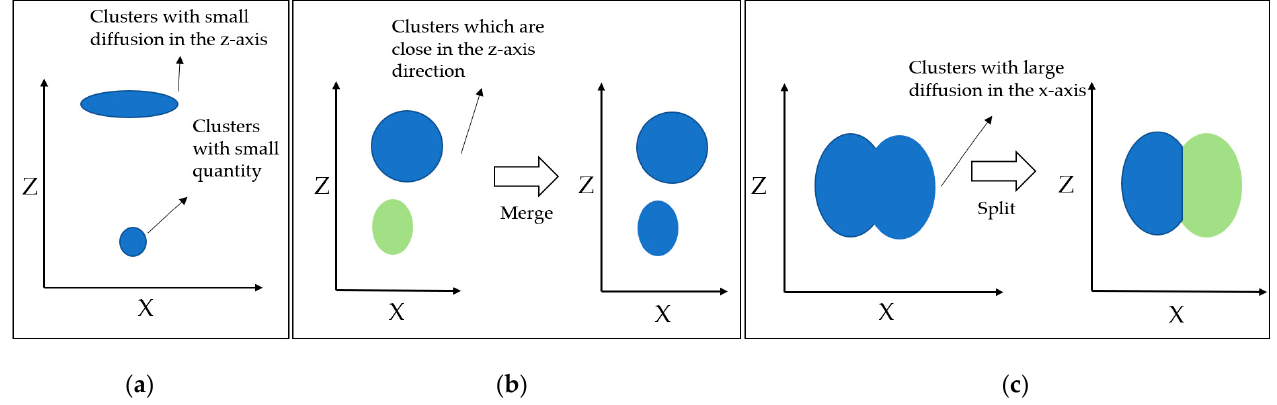
Figure 6. Target clusters for post-clustering processing rules: ( a ) clusters with small diffusion in the z-axis and clusters with small quantities will be filtered; ( b ) clusters that are close in the z-axis direction will be merged; ( c ) clusters with large diffusion in the x-axis will be split. Different colors represent point clouds grouped into different categories.